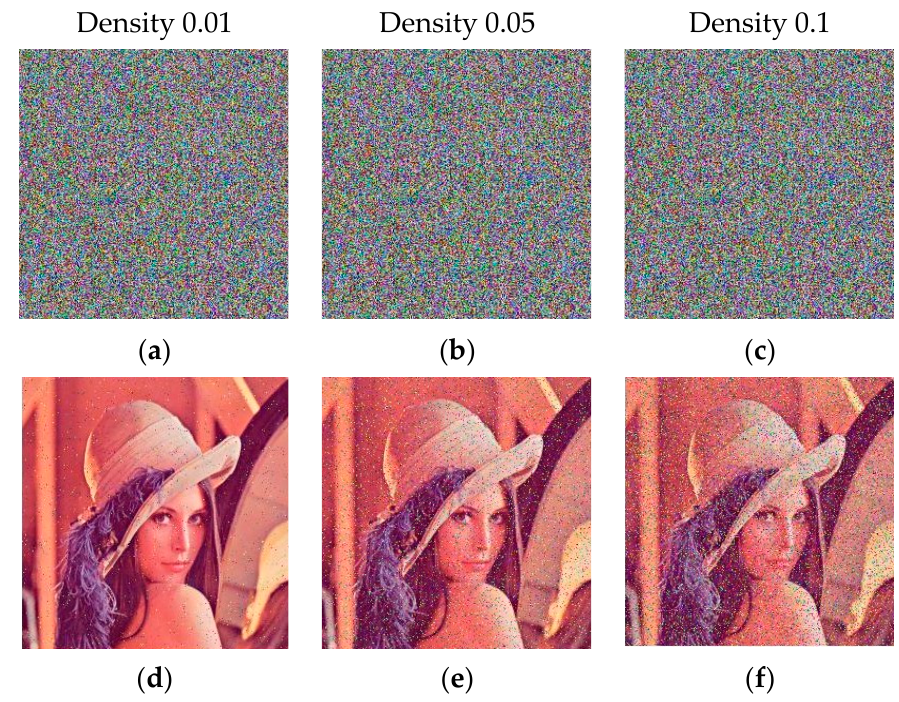
Figure 6. Noise attack analysis. ( a – c ) Noisy cipher images; ( d – f ) corresponding decrypted images.